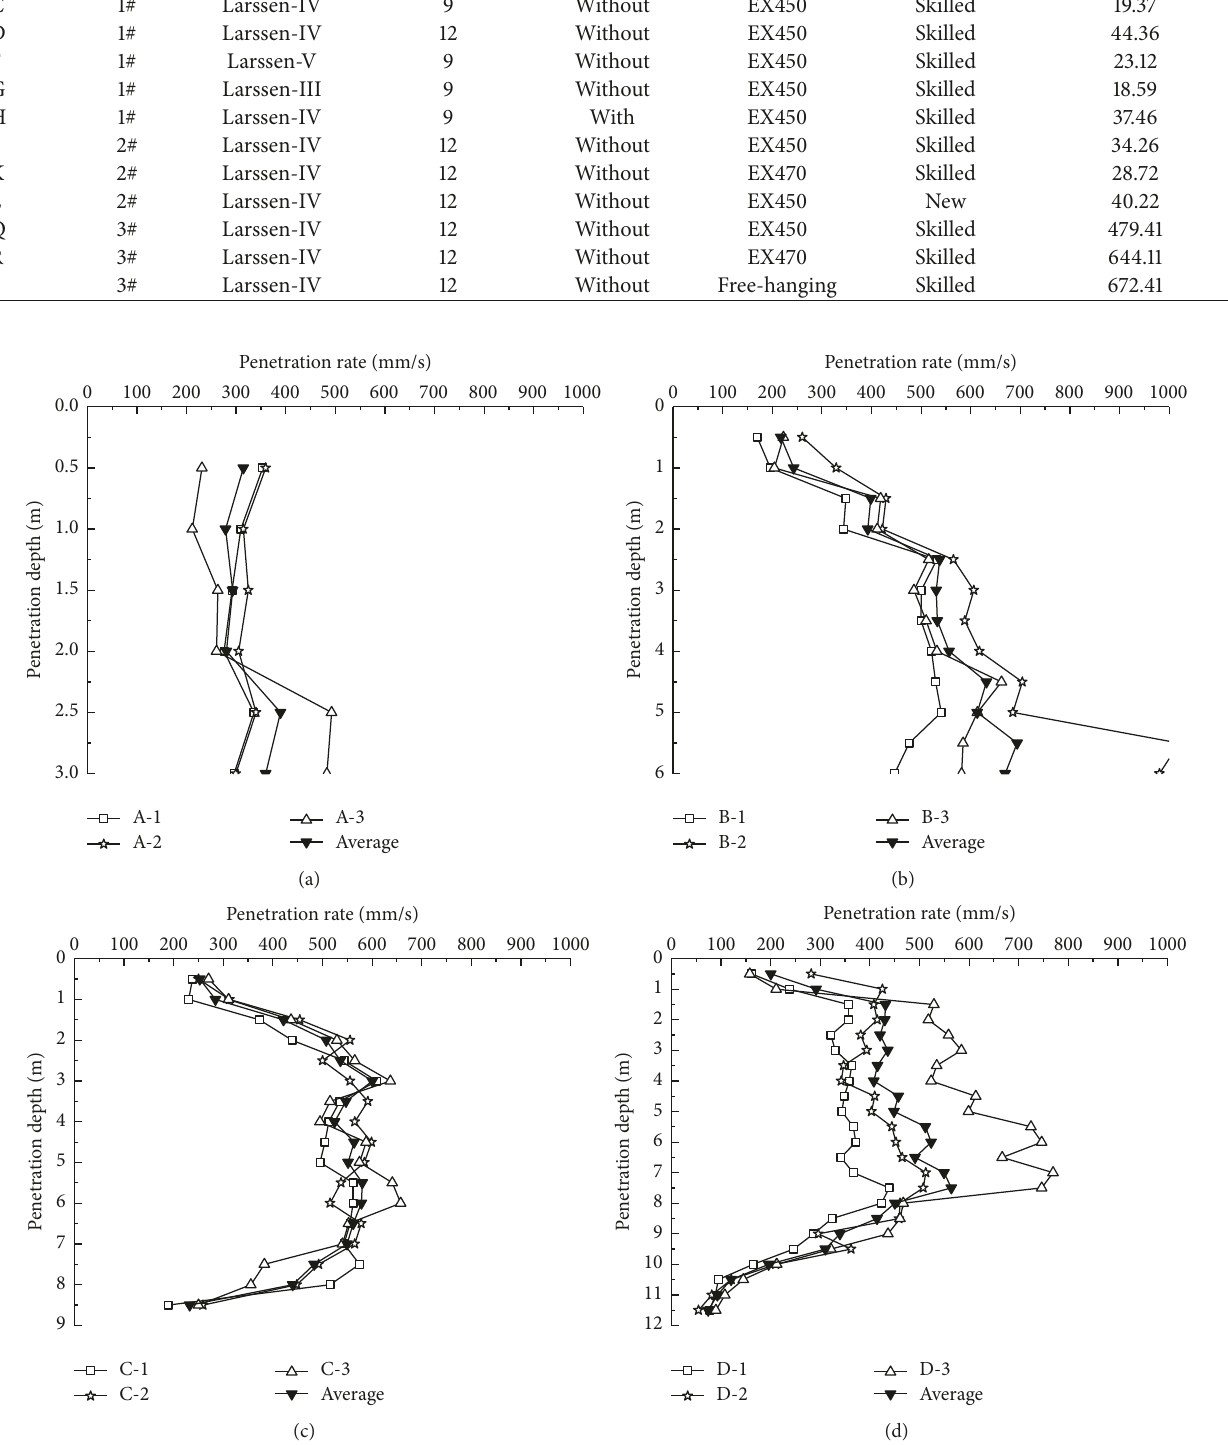
Figure 4: Penetration rate of piles from series A to series D versus penetration depth: (a) pile length = 3m, (b) pile length = 6m, (c) pile length = 9m, and (d) pile length =